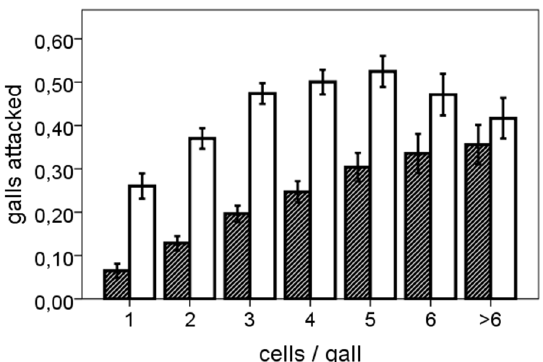
Figure 1. Average attack rate of galls by E. serratulae (black) and E. robusta (white) as function of cell numbers per gall. Analysed material: 260 gall samples with a total of 7,064 galls collected from 1976 to 1993 in eastern France, southern Germany and eastern Austria.